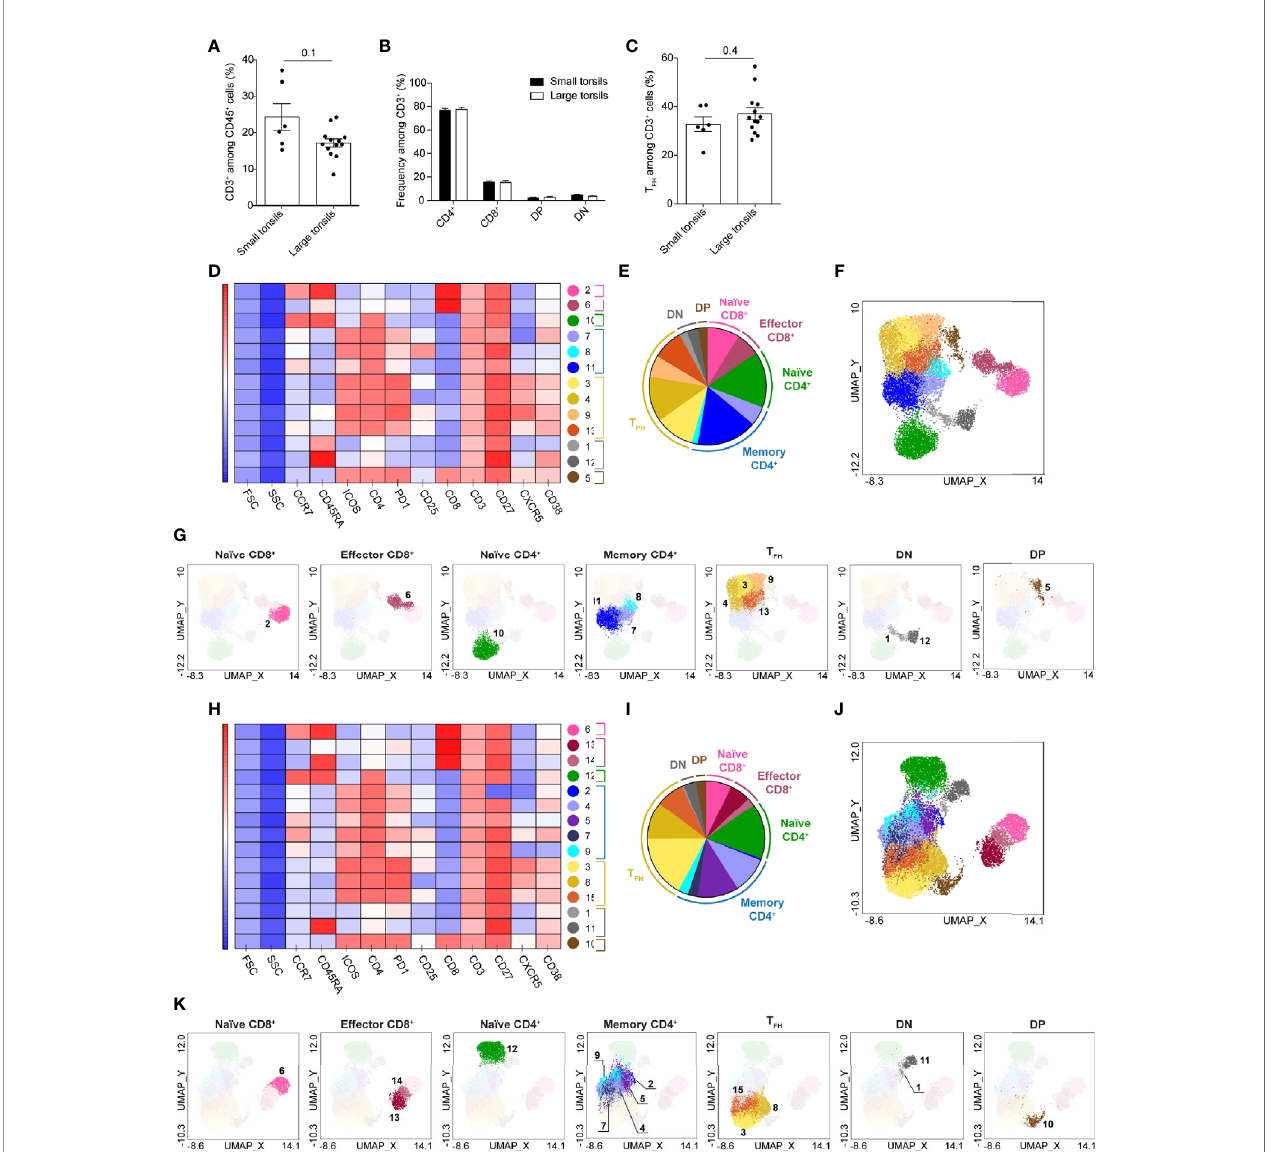
FIGURE 3 | T-cell clusters in tonsils of pediatric patients with OSA. (A) Frequency of CD3 + T cells among total living CD45 + cells. (B) Frequency of CD4 + , CD8 + , DP and DN T cells among total CD3 + cells. (C) Frequency of T FH cells among total T cells. (A – C) Bars and error bars indicate mean ± SEM. Statistical signi fi cance was calculated using Mann-Whitney U test. (D – K) T-cell clusters in small (D – G) and large (H – K) tonsils from patients with OSA, identi fi ed by PhenoGraph in the concatenated fi les. (D, H) Heatmap of marker expression intensity scaled individually for each marker. (E, I) Diagram showing proportions of PhenoGraph clusters and combined functional groups. (F, G, J, K) PhenoGraph clusters overlaid on the corresponding UMAP together (F, J) or separated by functional group (G, K)